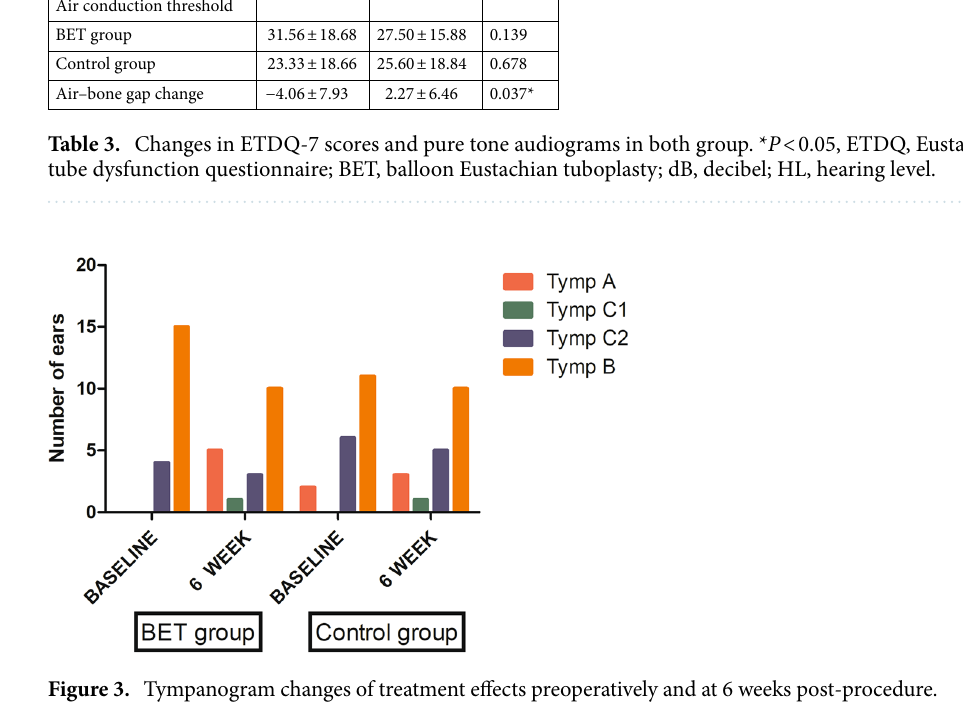
Figure 3. Tympanogram changes of treatment effects preoperatively and at 6 weeks